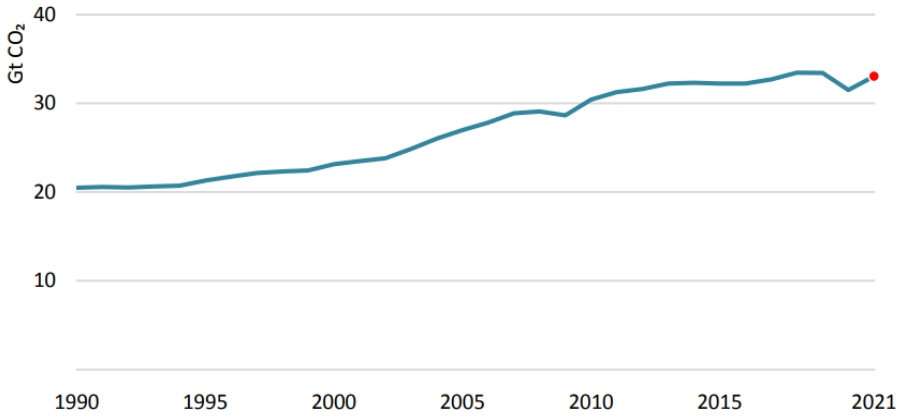
Figure 7. Energy-related CO 2 emissions in 2020–2021 [73]. Source: IEA (2021) Global energy- CO 2 emissions, 1990–2021. All rights related CO2 emissions, 1990-2021. All rights reserved.